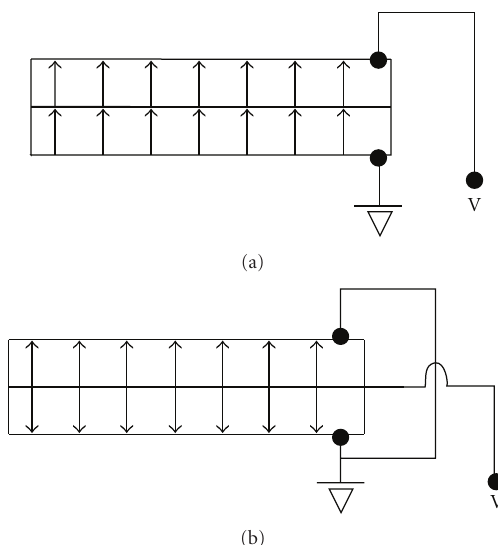
Figure 4: (a) Series and (b) parallel type configuration for extender